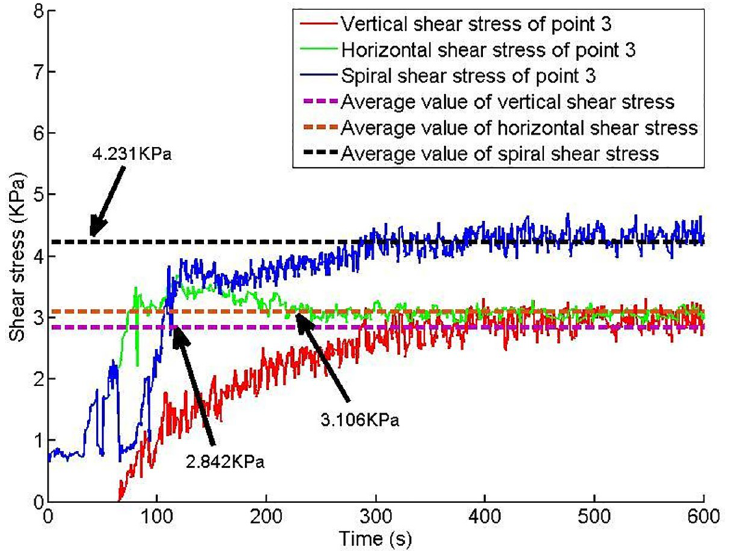
Fig 15. Shear stress of testing point 3.